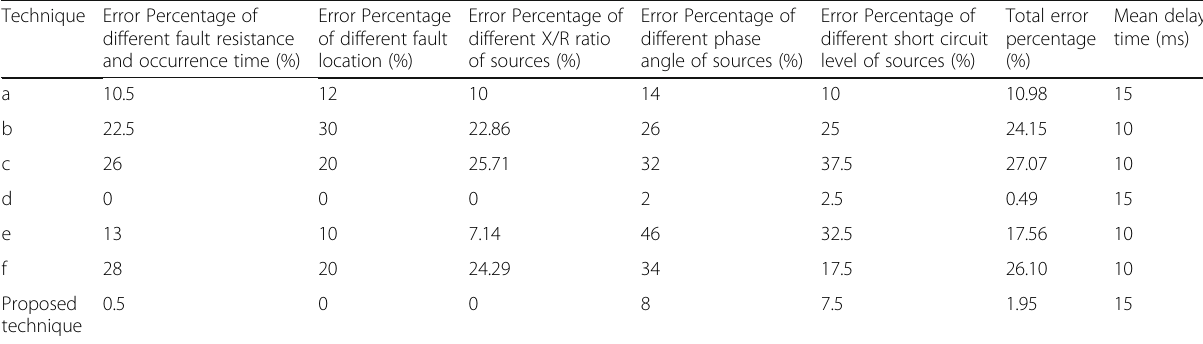
Table 8 Comparison between the different methods Technique Error Percentage of different fault resistance and occurrence time (%)